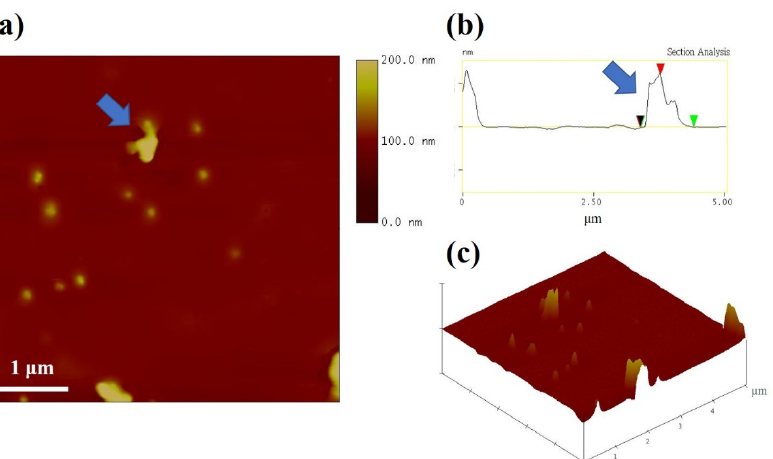
Figure 4. AFM images of the PNI-C 60 : ( a ) Top-view; ( b ) Section analysis; ( c ) Side-view. The blue arrows show a PNI-C 60 which was used to calculate the diameter. The black, red, and green marks in Figure 4( b ) was used to measure the horizontal distance and vertical distance.